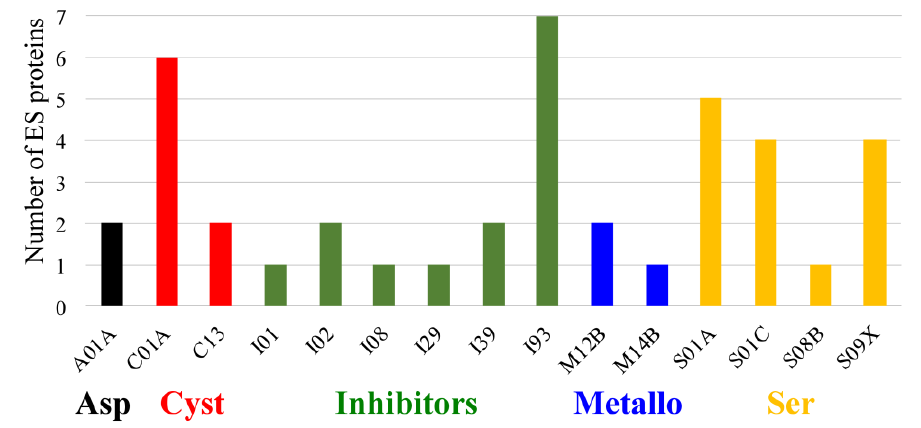
Figure 3. Peptidase families (Asp: aspartic peptidases, Cyst: cysteine peptidases, Inhibitors, Metallo: metallopeptidases, Ser: serine peptidases), and subfamily identifiers in predicted ES pro- teins.